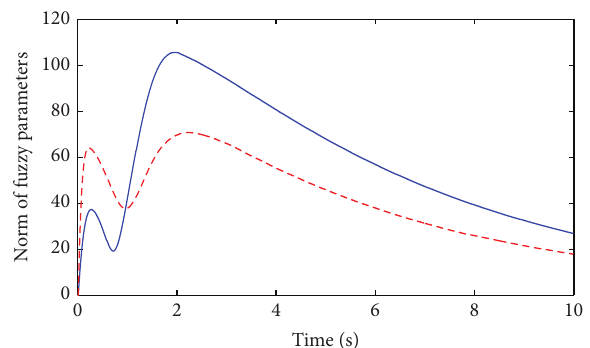
Figure 4: Time response of the fuzzy system parameters: ‖𝜃 1 ‖ (solid line) and ‖𝜃 2 ‖ (dashed